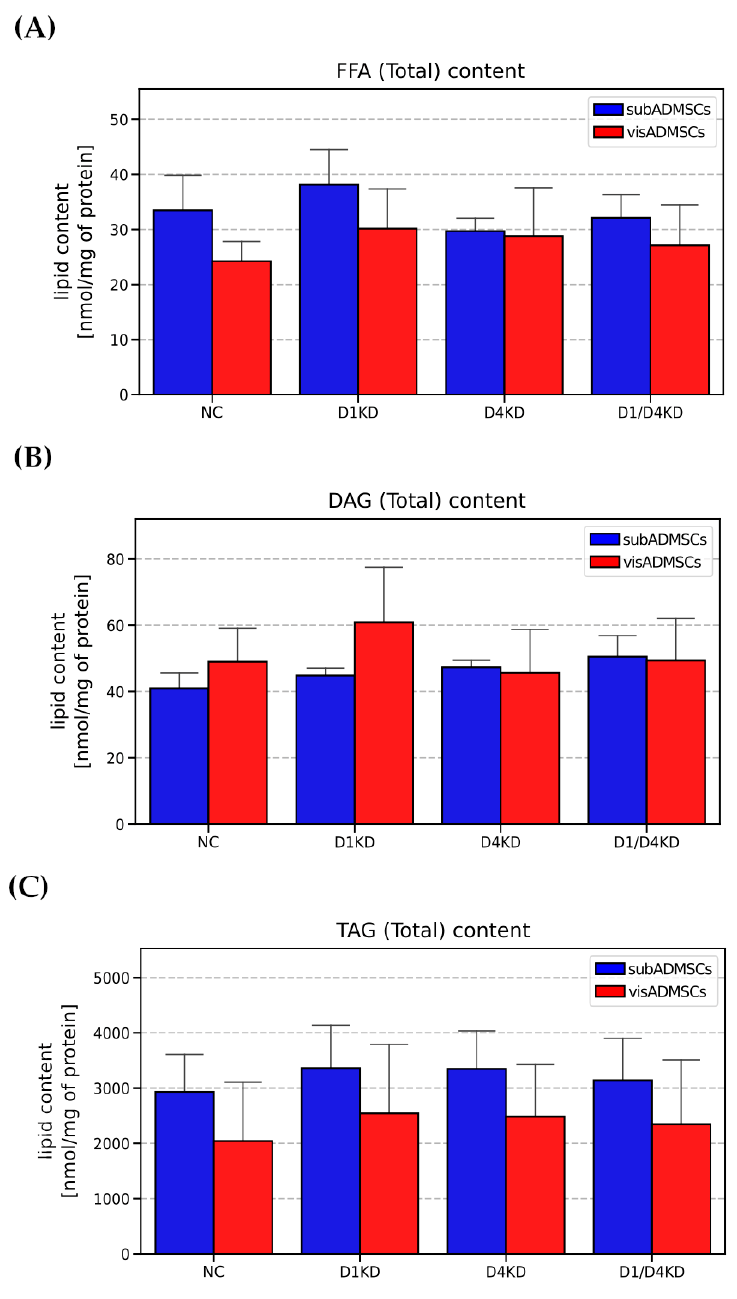
Figure 11. Total FFA ( A ), DAG ( B ), and TAG ( C ) content in TBC1D1- and/or TBC1D4-deficient adipocytes. Bars and whiskers represent the mean and SD respectively. Number of patients equals four (measurements taken in triplicate). Values are expressed in nmol per mg of protein. Designation of the groups: NC—negative control containing non-targeting siRNA fragment; D1KD—knockdown of TBC1D1 ; D4KD—knockdown of TBC1D4 ; D1/D4KD—double knockdown of TBC1D1 and TBC1D4 .